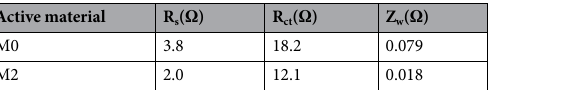
Active material